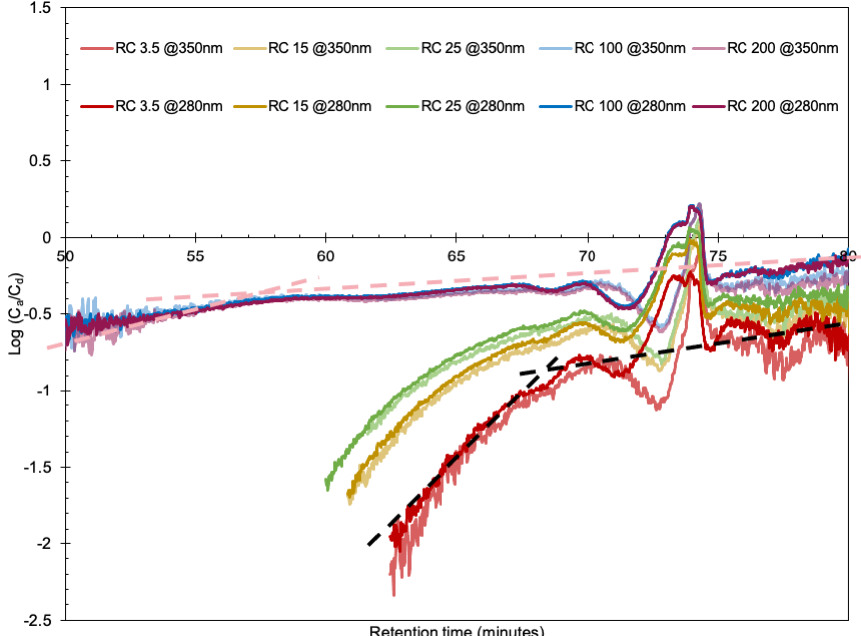
Figure 4. Log(C a /C d ) versus retention time. The dashed lines show the point at which the diffusion mechanism changed in the RC3.5 and RC100 membranes.